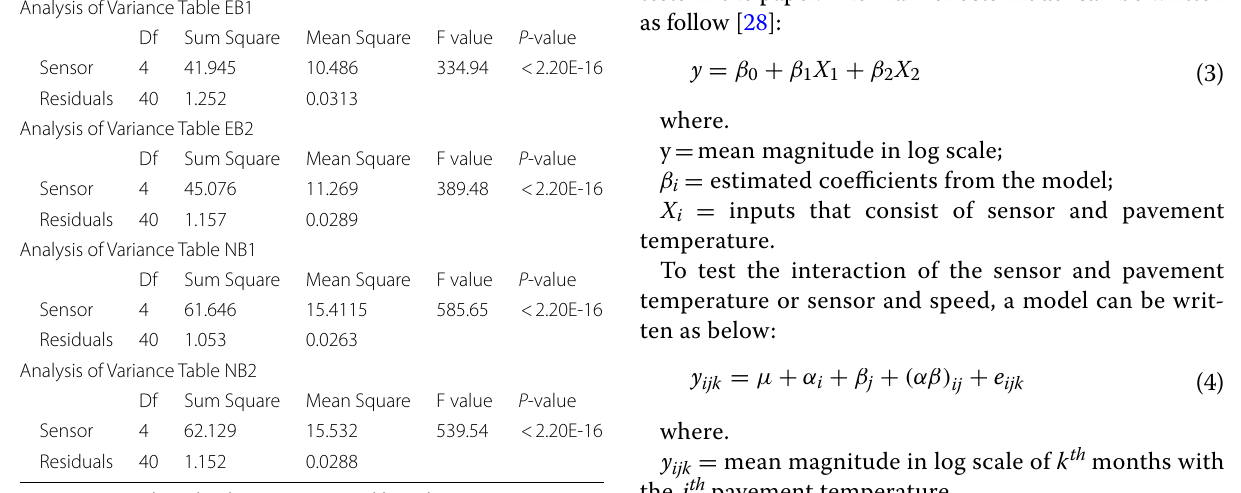
EB represents eastbound and NB represents northbound